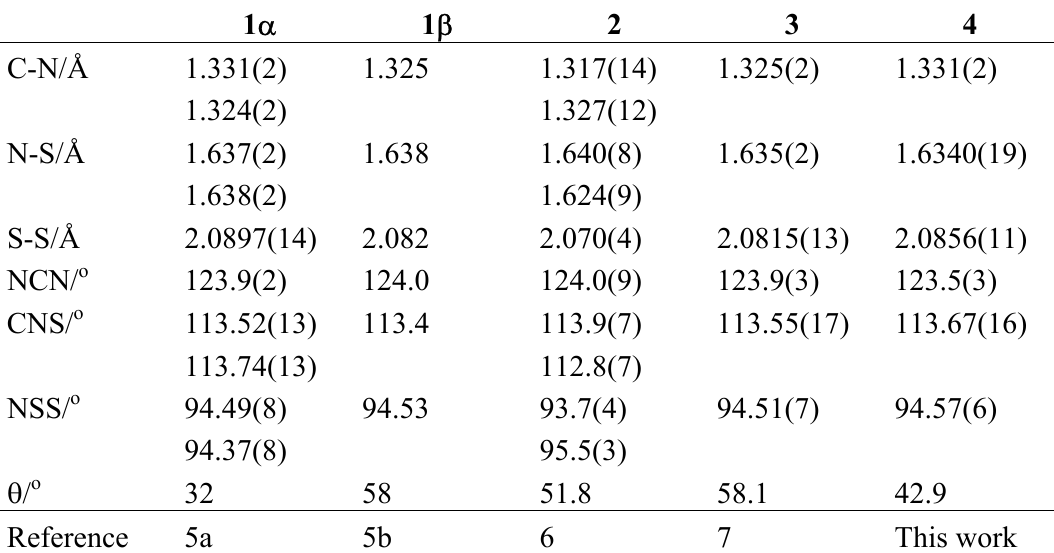
Heterocyclic bond lengths and angles for 1 - 4 . The angle θ represents the angle between CN